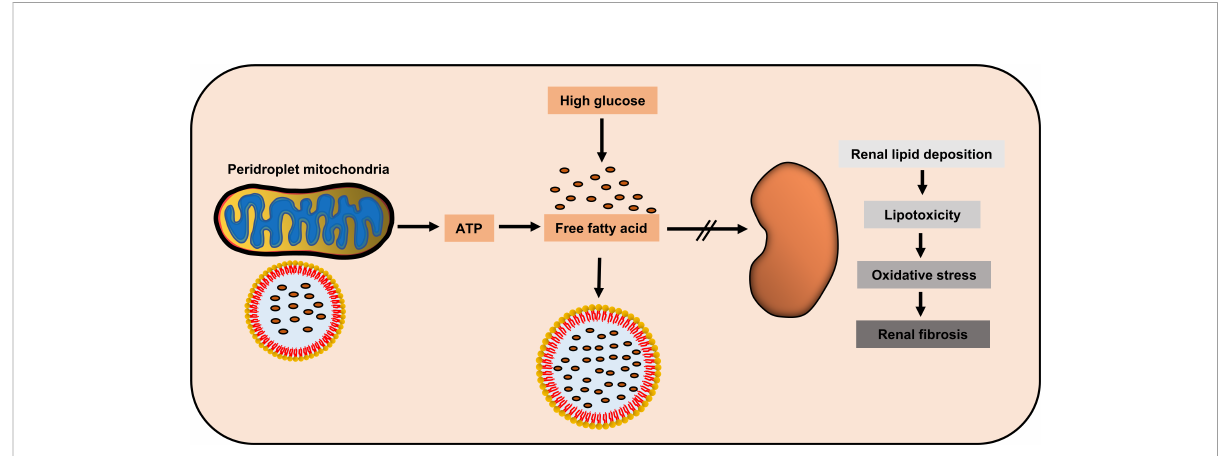
FIGURE 2 Potential renal protection of peridroplet mitochondria (PDM) in diabetic nephropathy. High glucose could induce the kidney to produce high amount offree fatty acids, while PDM generate ATP to promote lipotoxic fatty acids transfer into lipid droplets to be isolated, to protect kidney